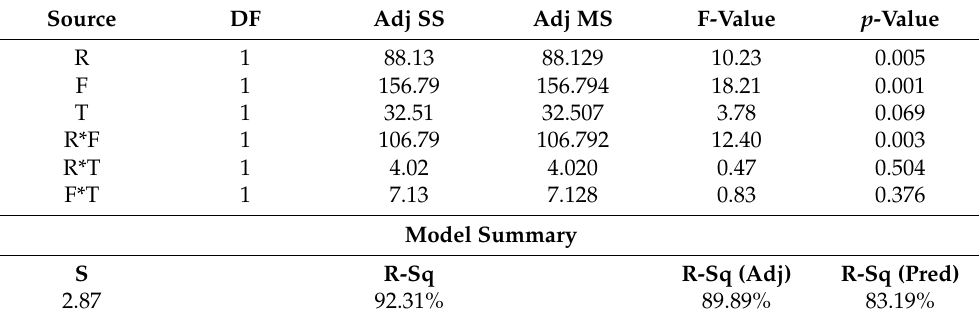
Table 6. Analysis of variance for friction stir welding.